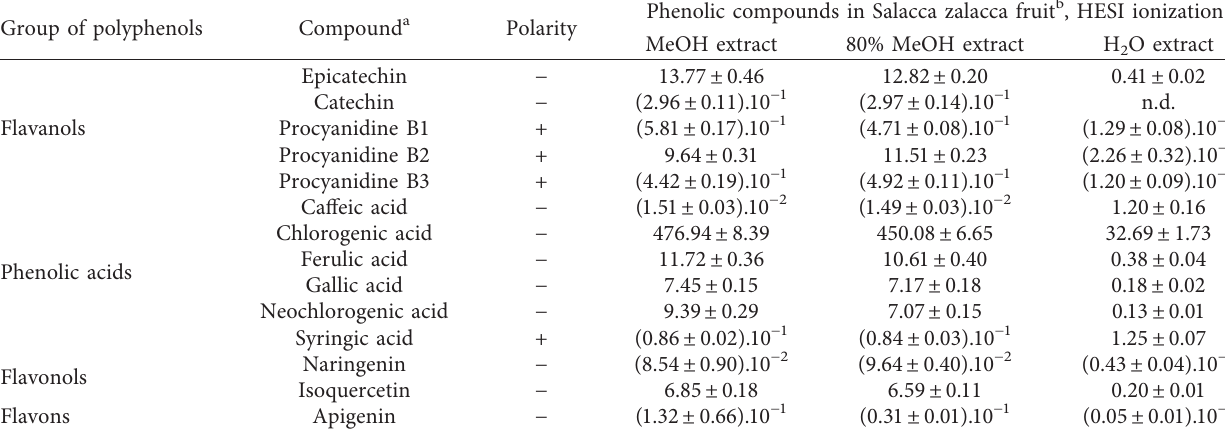
Table 2: Contents of individual phenolic compounds determined in Salacca zalacca fruit pulp. n.d.: not determined. Group of